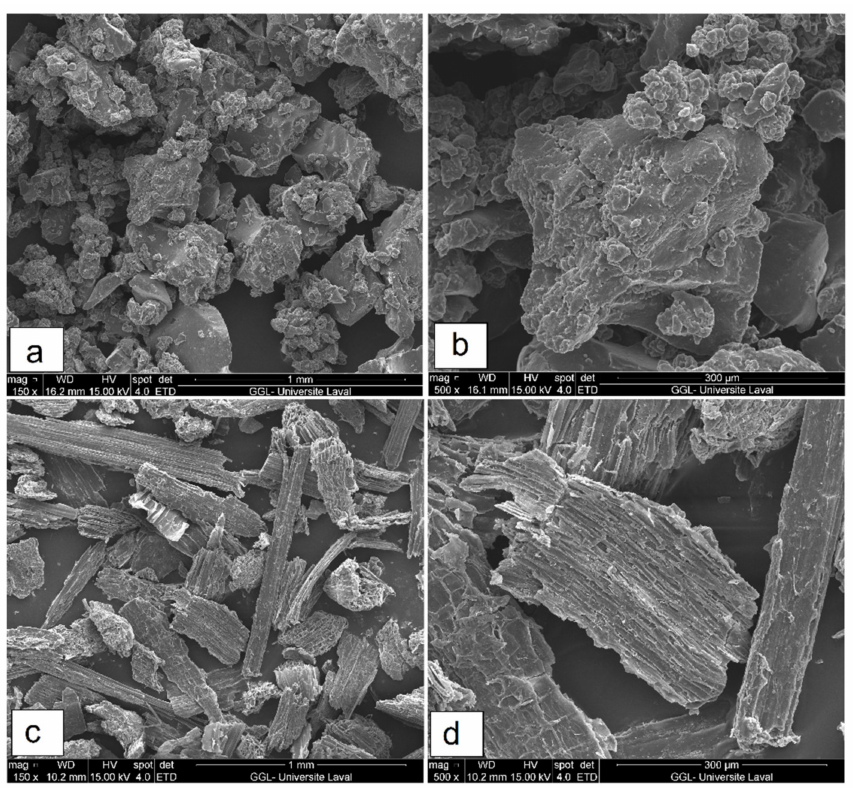
Figure 1. SEM micrographs of ( a , b ) RR and ( c , d ) FF particles at different